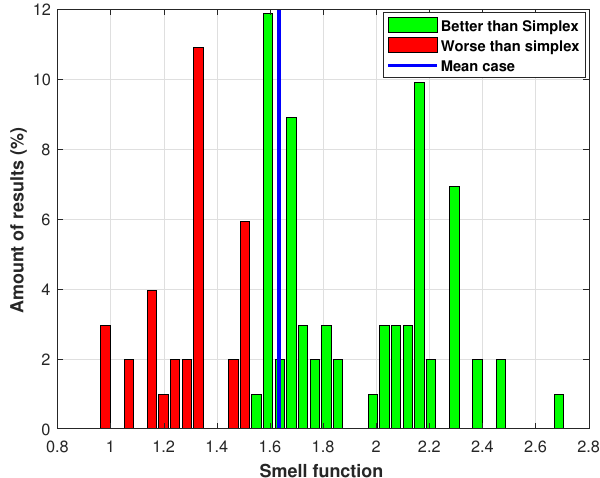
Figure 16. Histogram of the smell function values achieved during the statistical